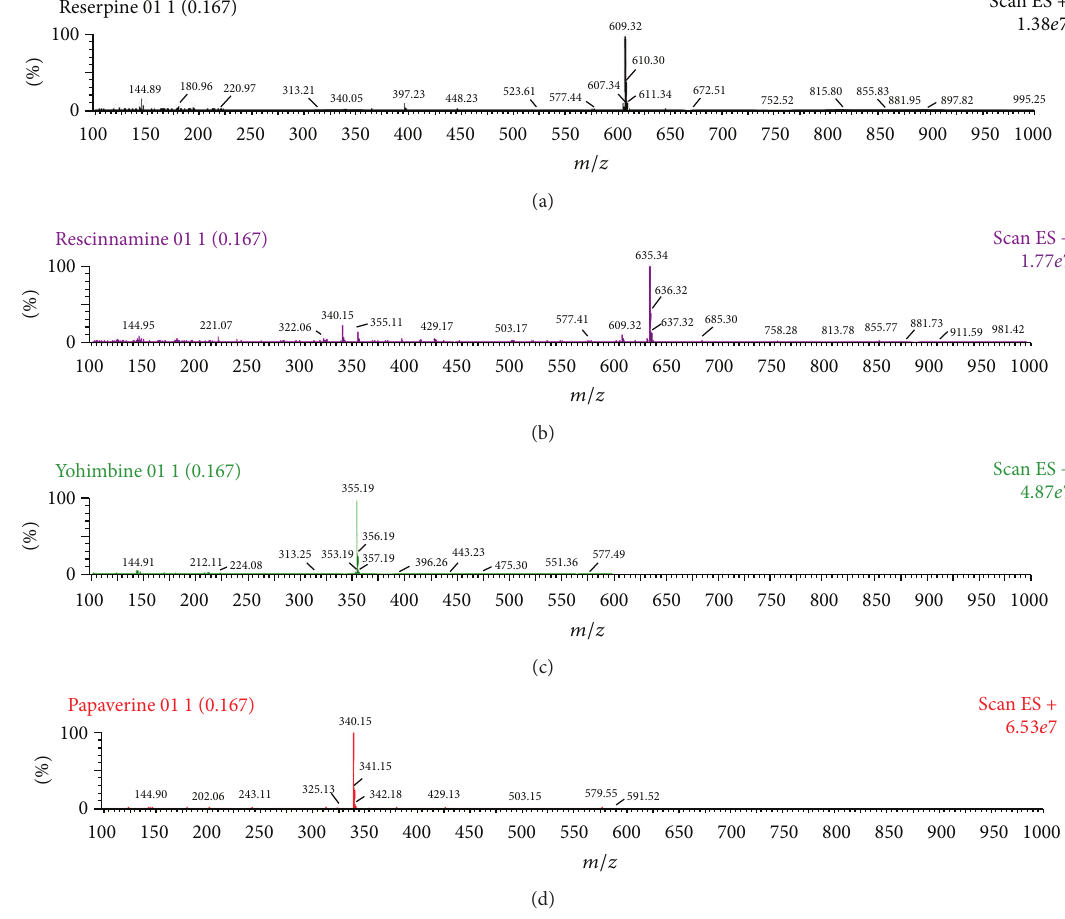
Figure 2: The MS spectra (parent ion) of reserpine (a), rescinnamine (b) yohimbine (c) and papaverine